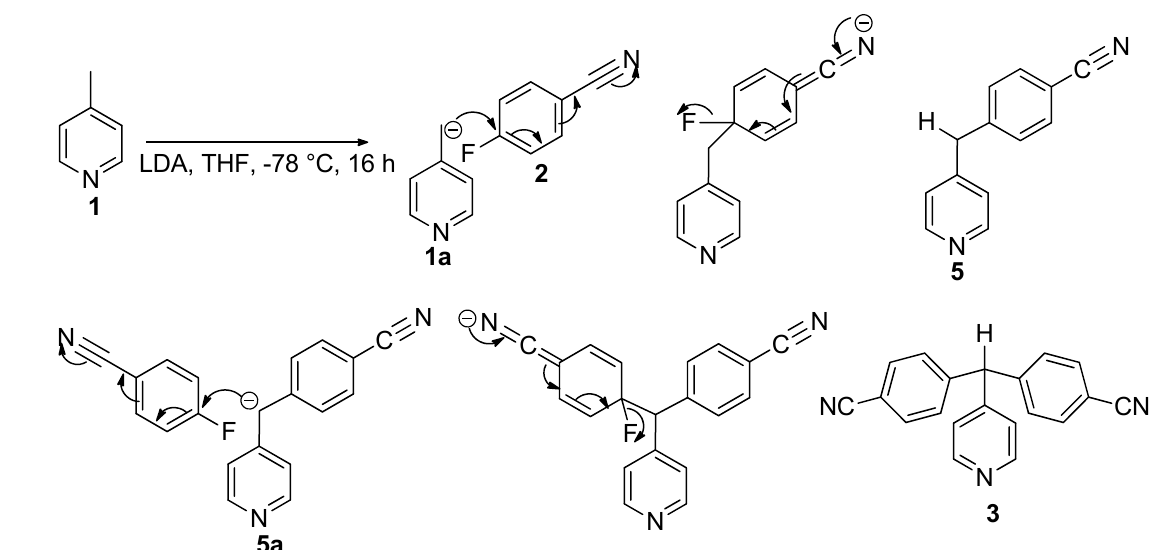
Figure 3. The proposed mechanism for the formation of the title compound 3 .